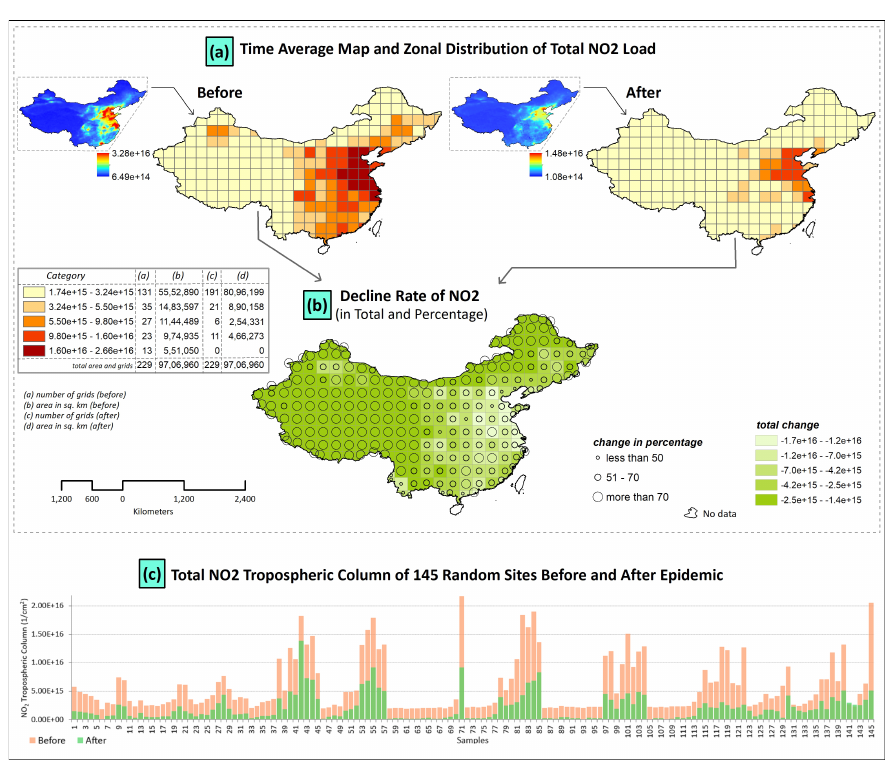
Figure 6. ( a ) Time average map and zonal distribution of the NO 2 tropospheric column, ( b ) declining rate (in total and percentage) of NO 2 , ( c ) trend analysis of the total NO 2 tropospheric column of 145 random sites of China’s mainland before and after pandemic. Source: OMI, Global Modeling and Assimilation Office,